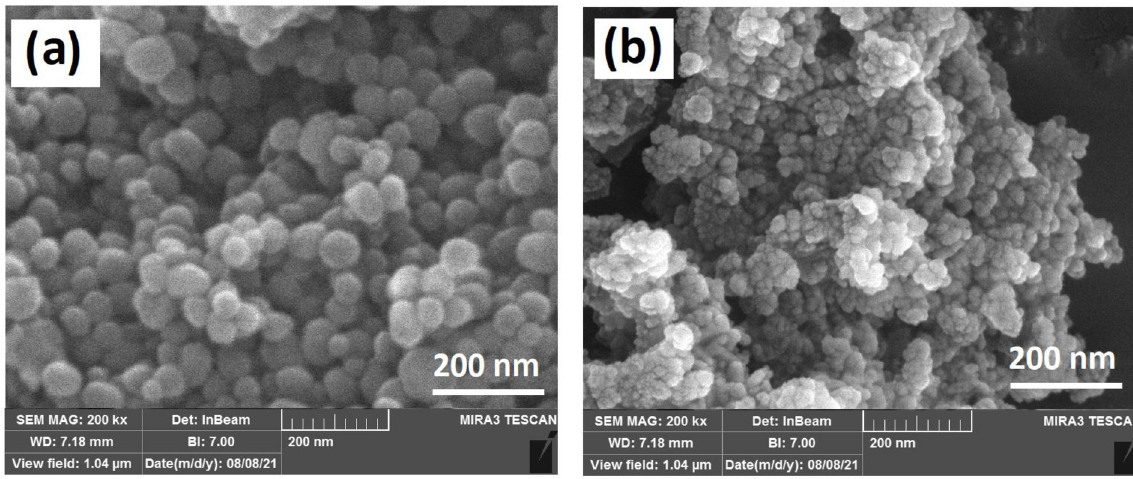
Fig 6. FESEM images of (a) CS-SiO 2 NPs and (b) GS-SiO 2 NPs.